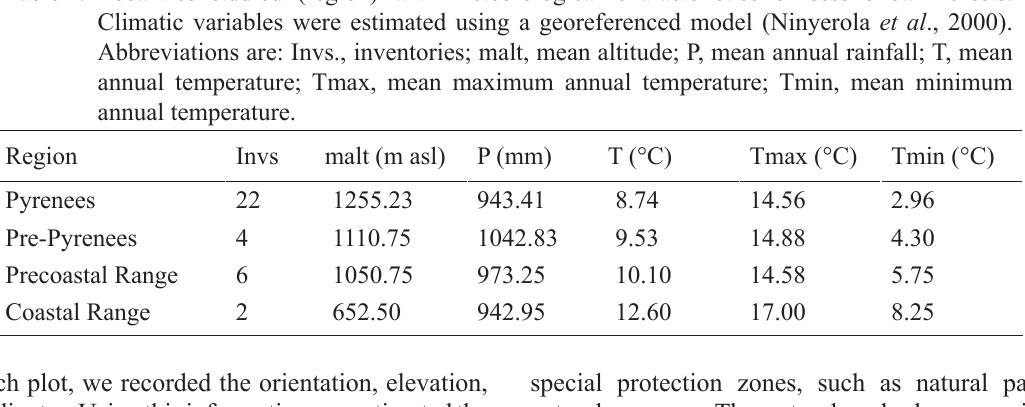
Table 1. Localities studied (region) with meteorological characteristics of sessile oak forests.